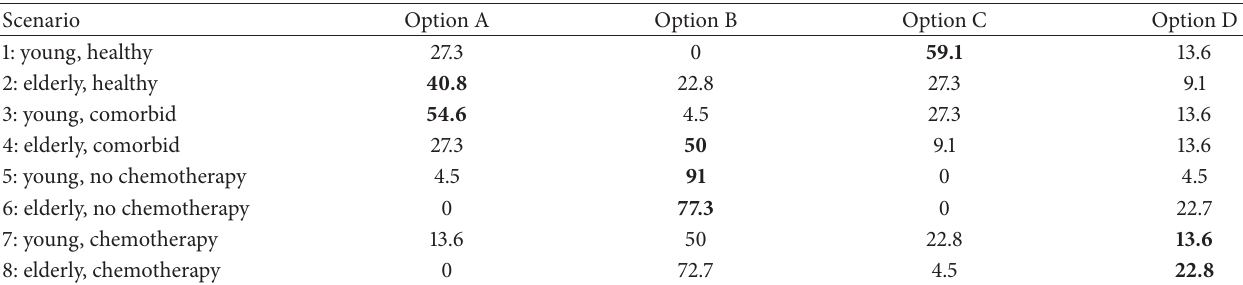
Table 4: A subgroup of respondents’ management decisions (measured in proportions, %) based on eight clinical scenarios of malignant large bowel obstruction or MLO (detailed in Box 1), with the optimal approach highlighted in bold, as suggested by the 2014